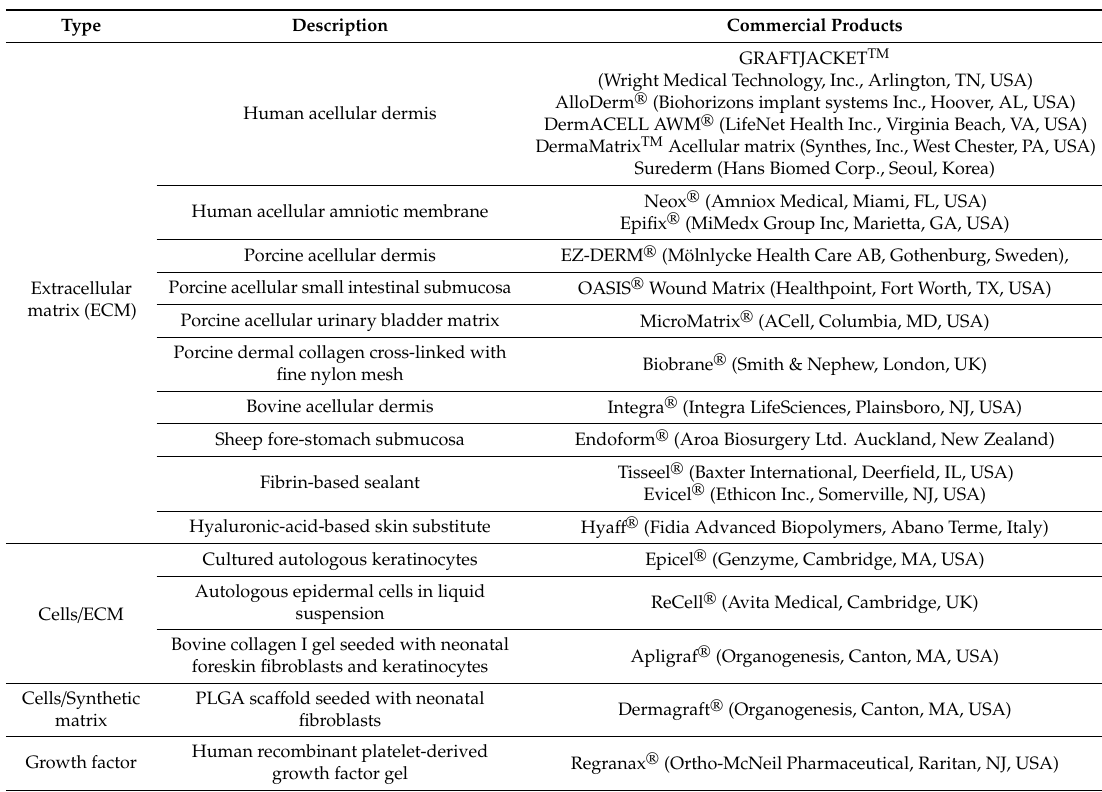
Table 1. Extracellular matrix-, cell-, and growth-factor-based products for the treatment of skin wounds and burns